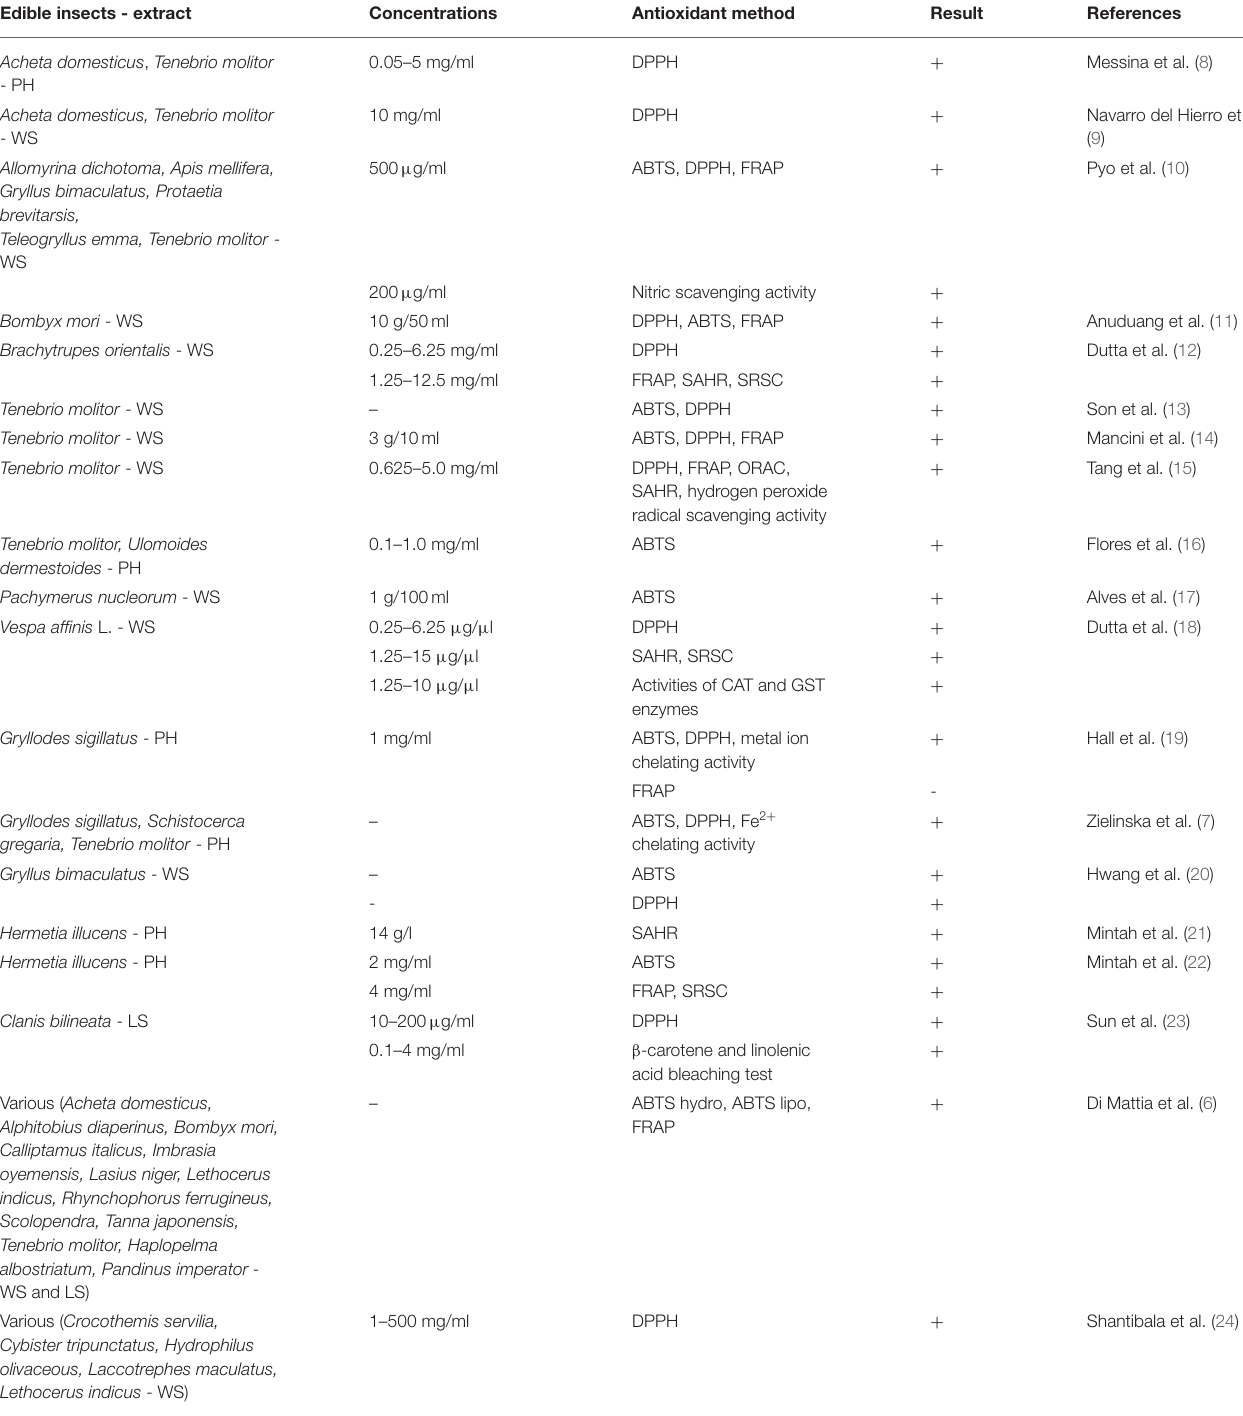
TABLE 1 | In vitro antioxidant activity of edible insects and invertebrates. Edible insects -